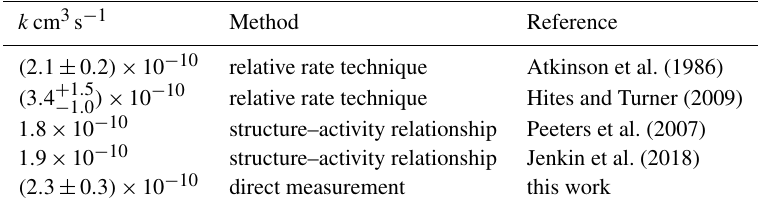
Table 4. Rate constants of the myrcene + OH reaction at 298K.